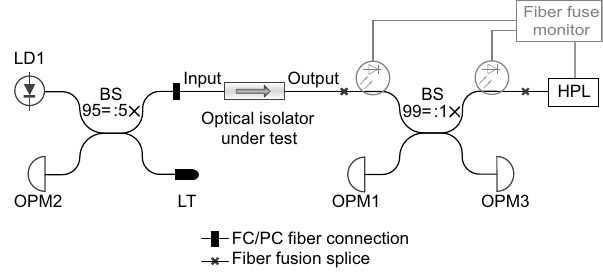
FIG. 1. Experimental setup for testing isolators. LD, laser diode; OPM, optical power meter; LT, light trap; HPL, high- power laser. The coupling ratio of the beam splitter (BS) denoted 95 = : 5 × means that 95% of light passes to the port horizontally opposite in the graphical symbol of the BS, while 5% of light is coupled across to the other